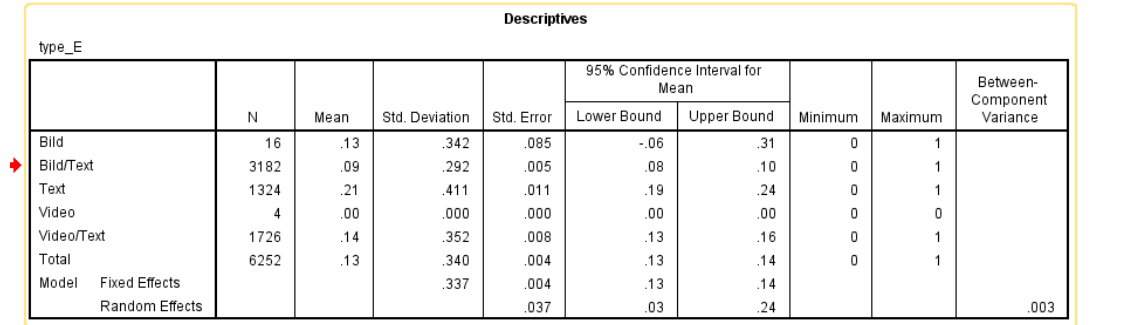
Figure 3. Number of Posts tagged with Text/Image/Video